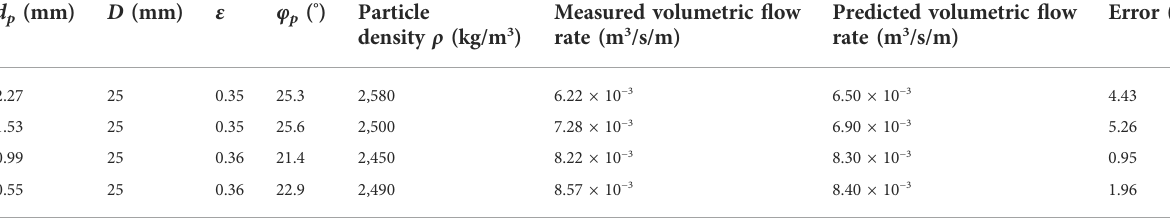
TABLE 1 Comparison of uniform-sized granular fl ow rates between experimental and analytical results.